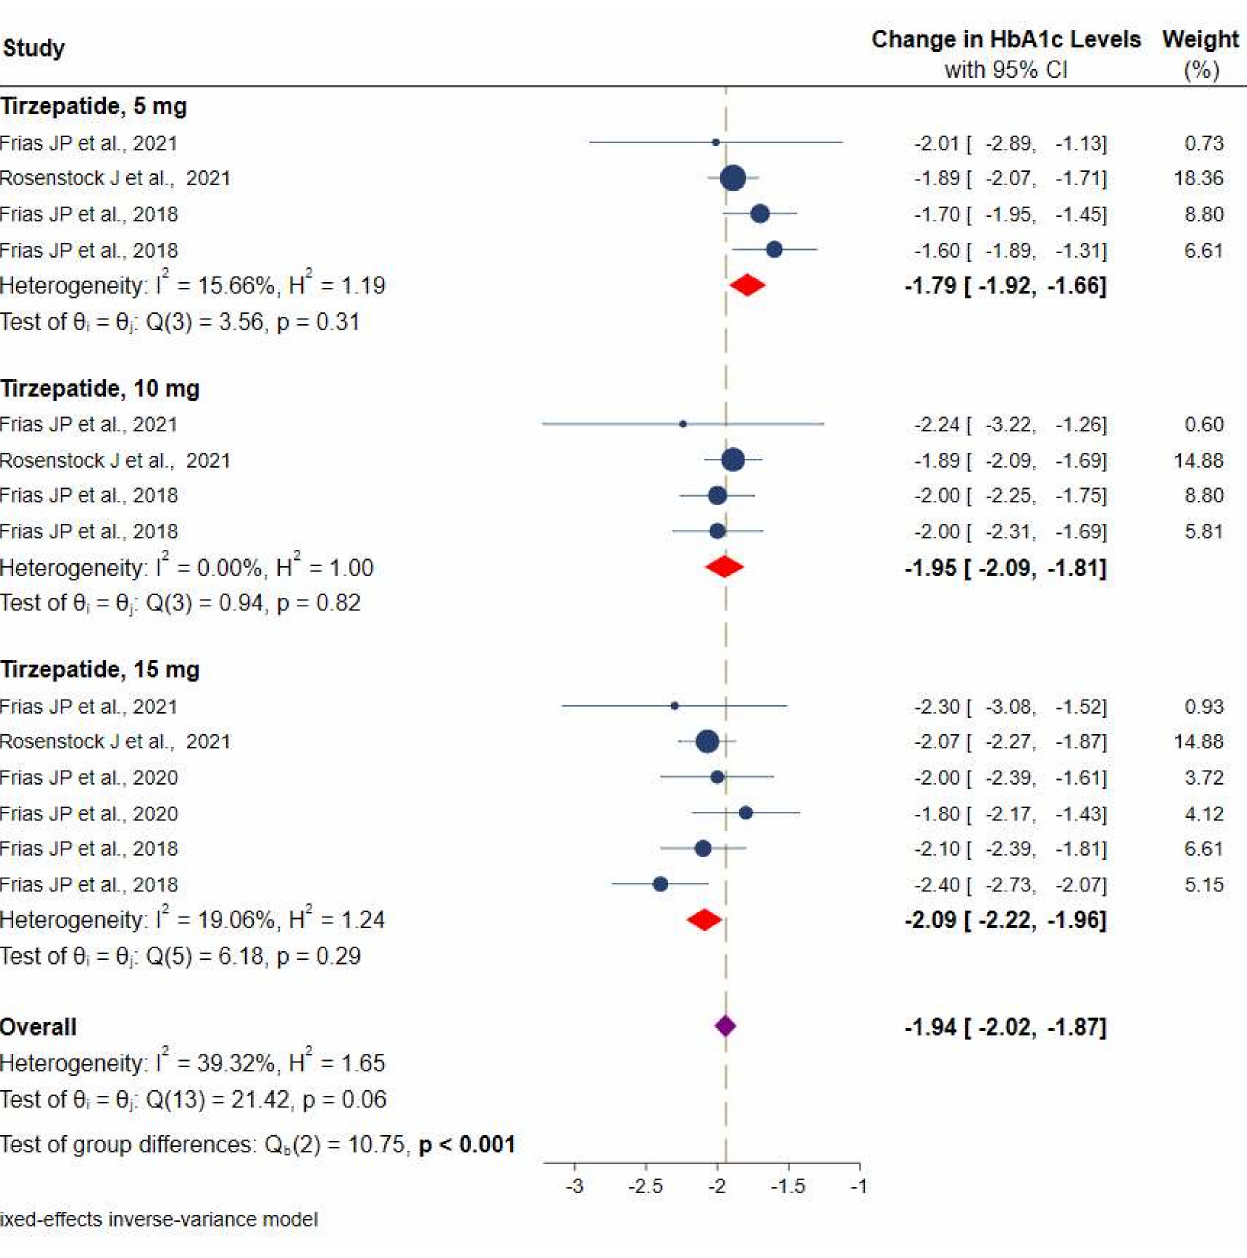
Figure 3. Effect of once-weekly tirzepatide on glycated hemoglobin